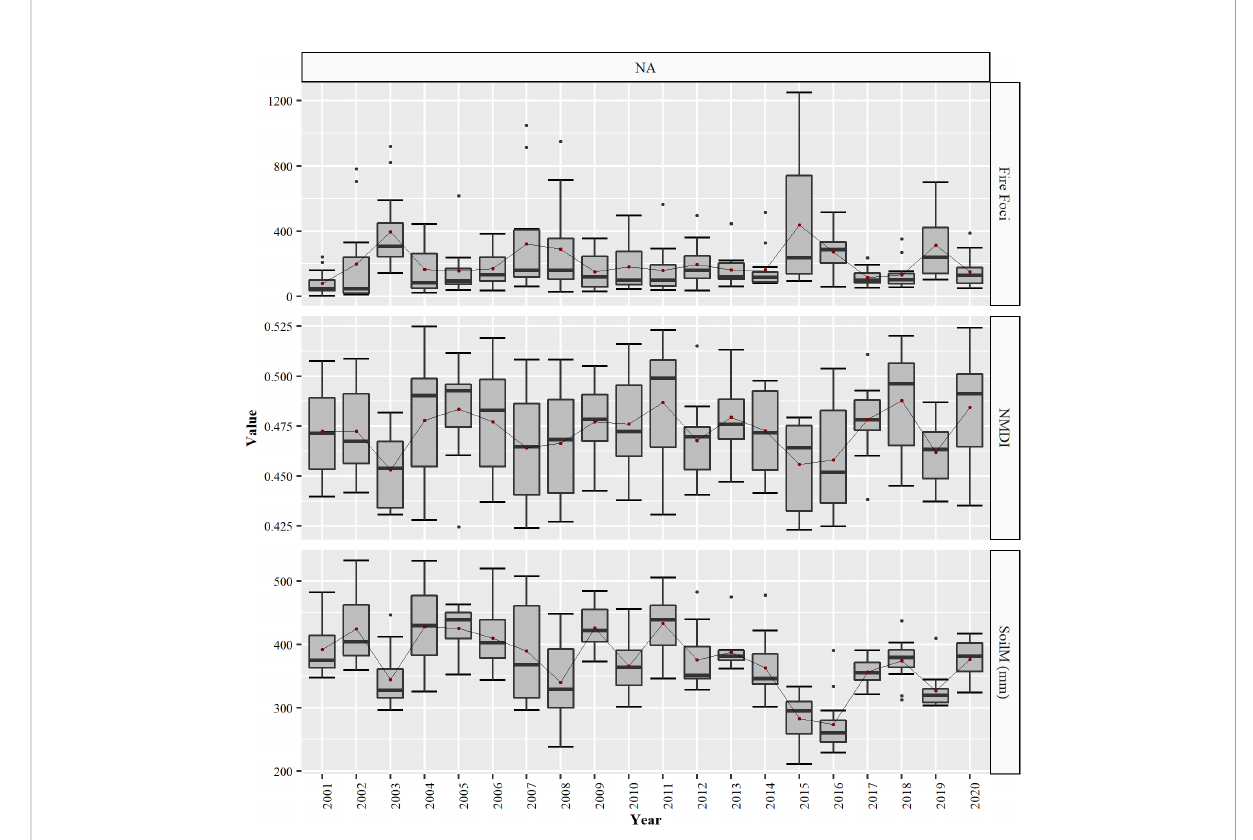
FIGURE 2 Boxplot of NMDI, fi re foci, and soil moisture [SoilM (mm)] variables in the Central Atlantic Forest